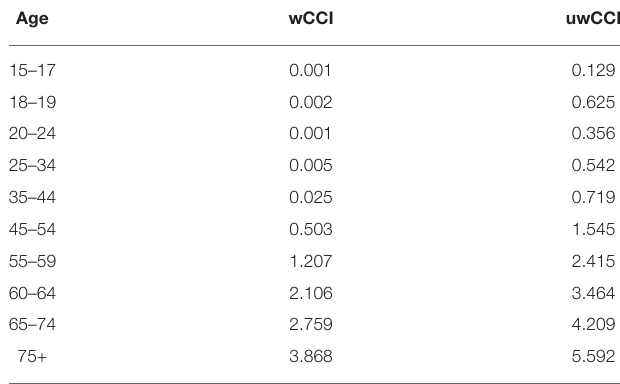
TABLE 3 | Weighted vs. unweighted